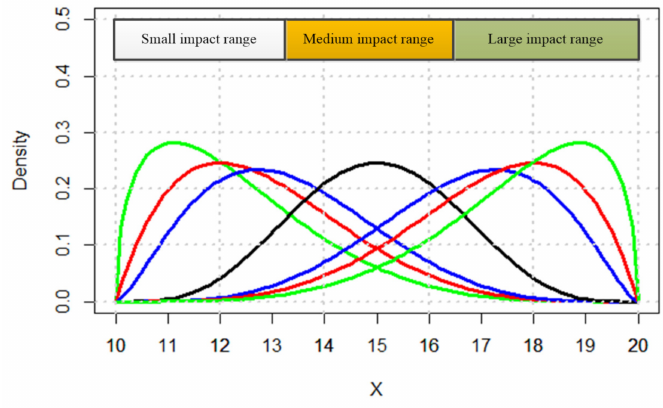
Figure 5. Calibration of risk impact